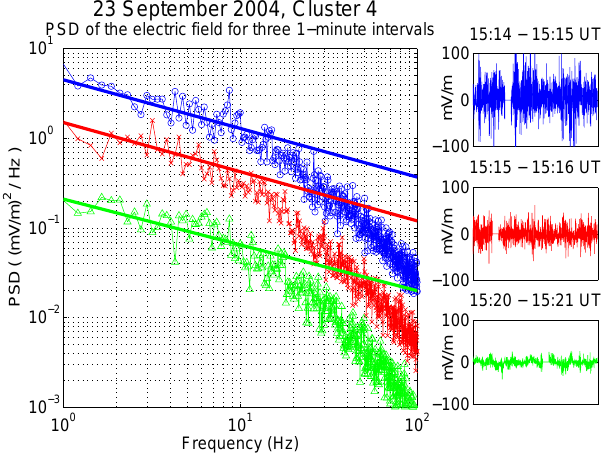
Fig. 9. Power spectral density (PSD) of the electric field observed by Cluster 4 during the 23 September 2004 cusp pass. Three one- minute intervals have been selected to show how the PSD graph changes for different fluctuation intensities. The electric field data are shown in the small panels on the right. The corresponding PSDs are shown with the same color in the main panel. At this time, the local proton gyrofrequency was 8.3Hz. There is a break in the PSD in the vicinity of the proton gyrofrequency. Thick lines have been added as a visual aid to emphasize the break in the